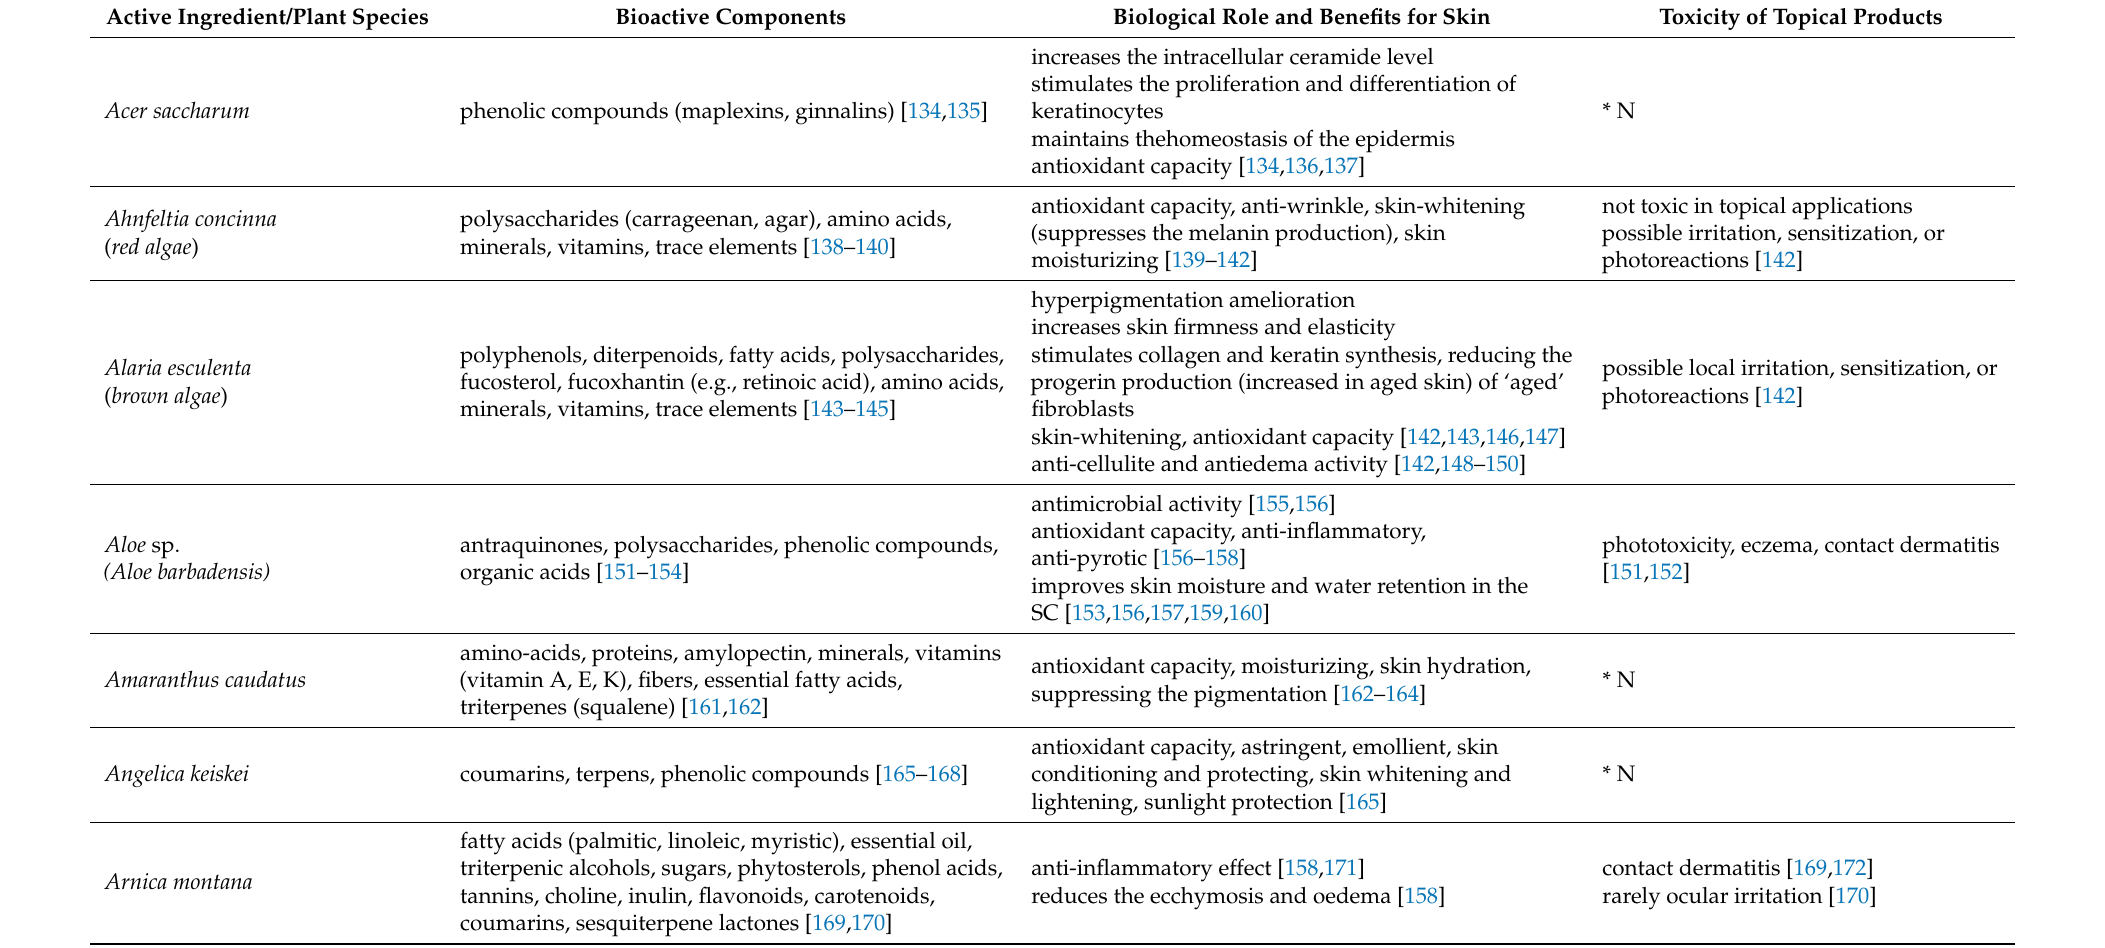
Table 2. The benefits and potential adverse effects of botanical extracts used in cosmetic products associated with hyaluronic acid and HA derivates. Active Ingredient/Plant